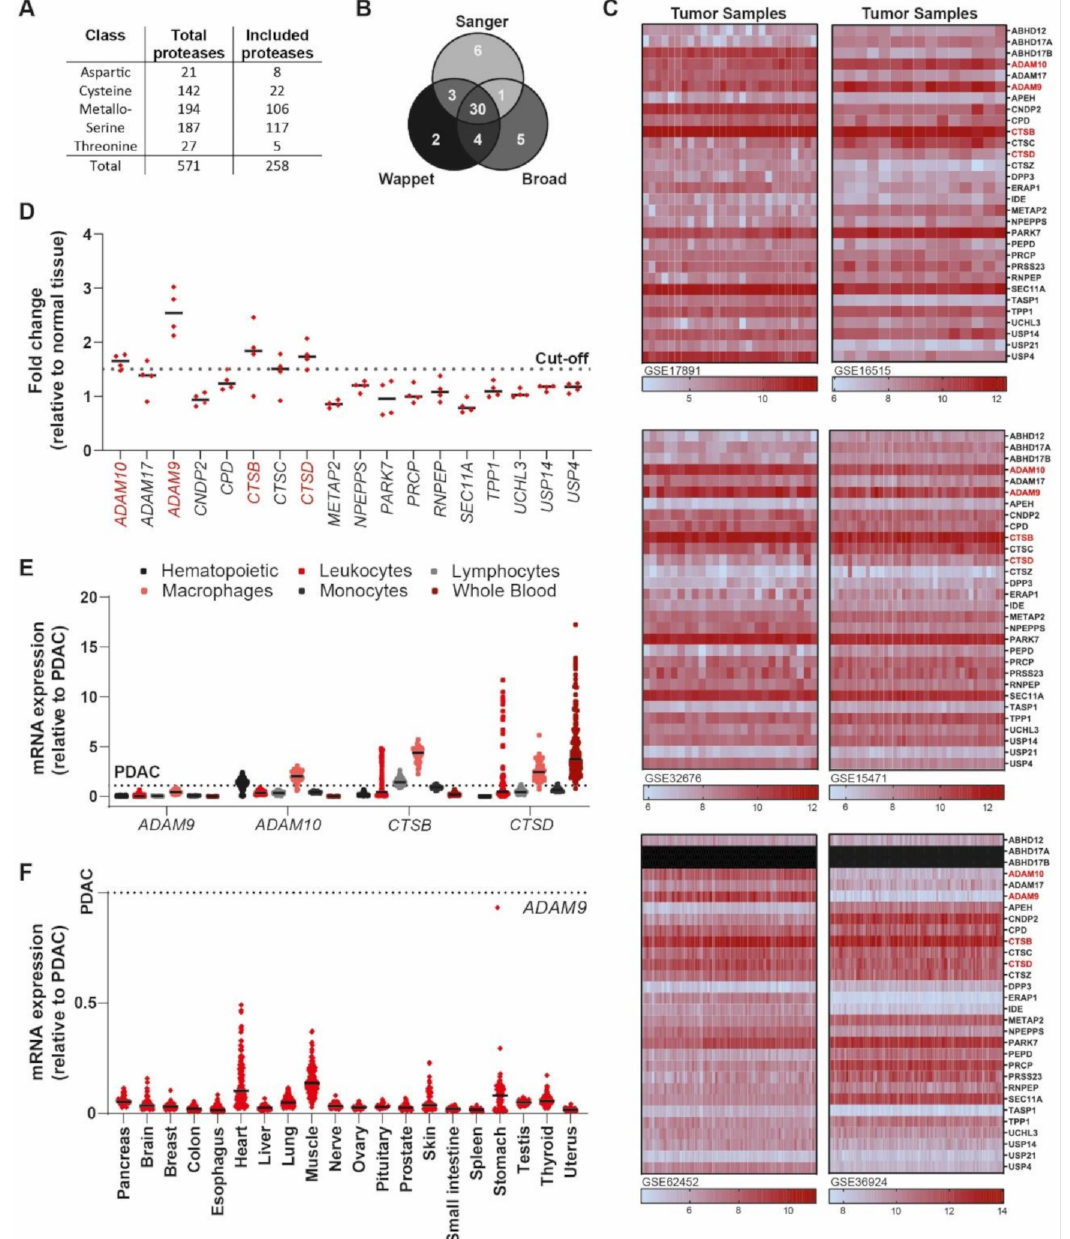
Figure 1. Identification of ADAM9 as a PDAC-enriched extracellular protease. ( A ) Overview of the total number of proteases in the genome and the number of extracellular proteases included in our analysis. ( B ) Venn diagram of the proteases with above-average expression in every PDAC cell line present in the Sanger (E-MTAB-783 [9]), Wappet (GSE57083), and Broad (GSE36133 [10]) datasets. ( C ) Heatmaps showing the expression of 30 upregulated proteases in six datasets involving 268 patients in total (GSE17891 [11], GSE16515 [12], GSE32676 [13], GSE15471 [14], GSE62452 [15], and GSE36924 [16] PDAC datasets). ( D ) Fold-change in expression levels of candidate proteases in patient-derived tumor biopsies, as compared with healthy adjacent pancreas sections. Indicated is the cutoff, set at a 1.5-fold increase. ( E ) Expression levels of selected